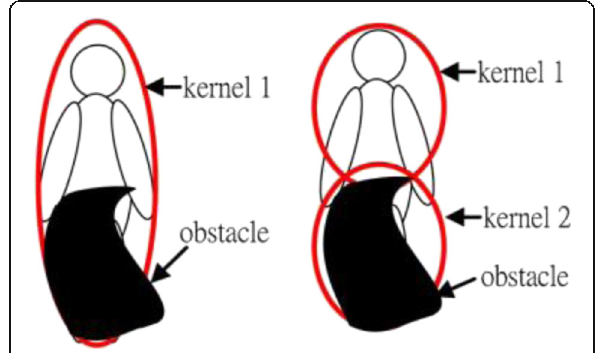
Fig. 4 Red ellipses represent kernels. Single kernel ( left ) and two kernels ( right ) with occlusion